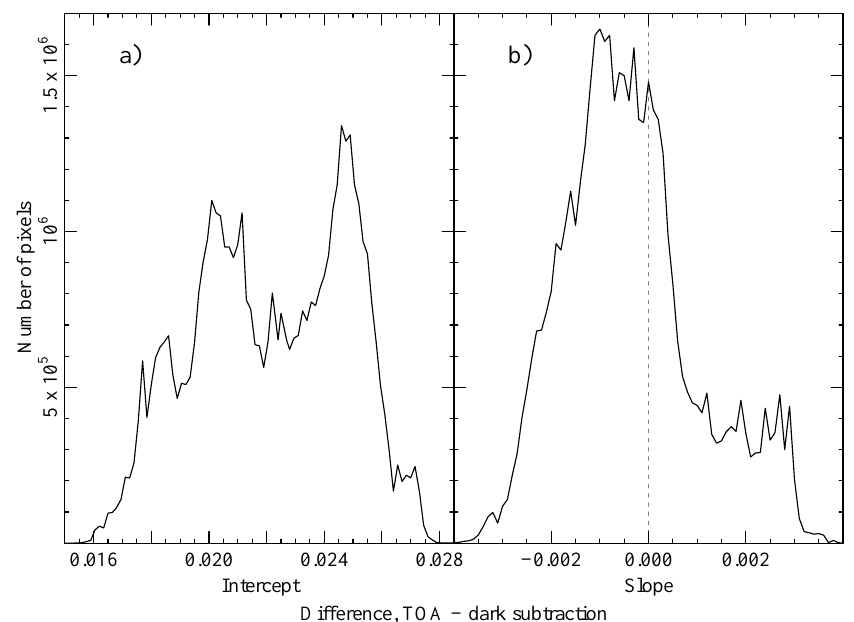
Figure A2. Histogram of the difference between TOA and dark subtraction regression coefficients for all pixels in the study area. ( a ) Distribution of the intercept difference (bin size = 0.00015). ( b ) Distribution of the slope difference (bin size = 0.0001). No difference is marked with a dashed